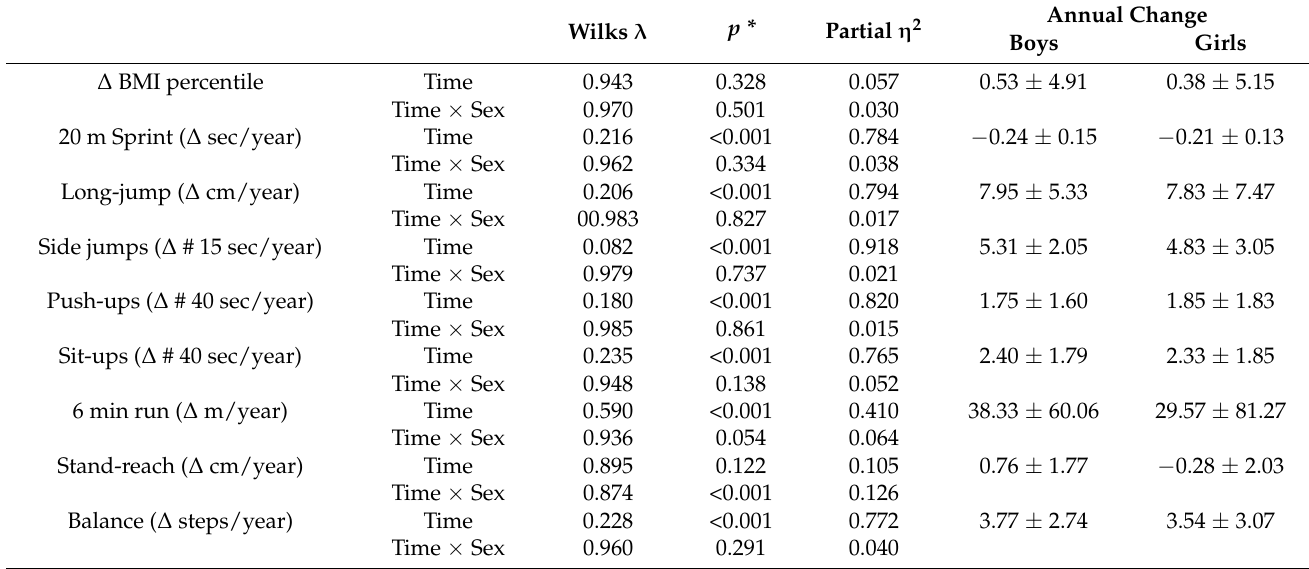
Time 0.960 0.040 Annual change values represent the mean ± SD. * p value indicates linear trend for time. The changes in speed, endurance, muscular power, and muscular strength, however, did not occur consistently throughout the year even though no seasonal difference was observed for the change in BMIPCT. Improvements in the 6 min run, push-ups, sit-ups, and standing long-jump were more pronounced during the summer months ( p < 0.01), while the improvement in the 20 m sprint was more pronounced during the school term